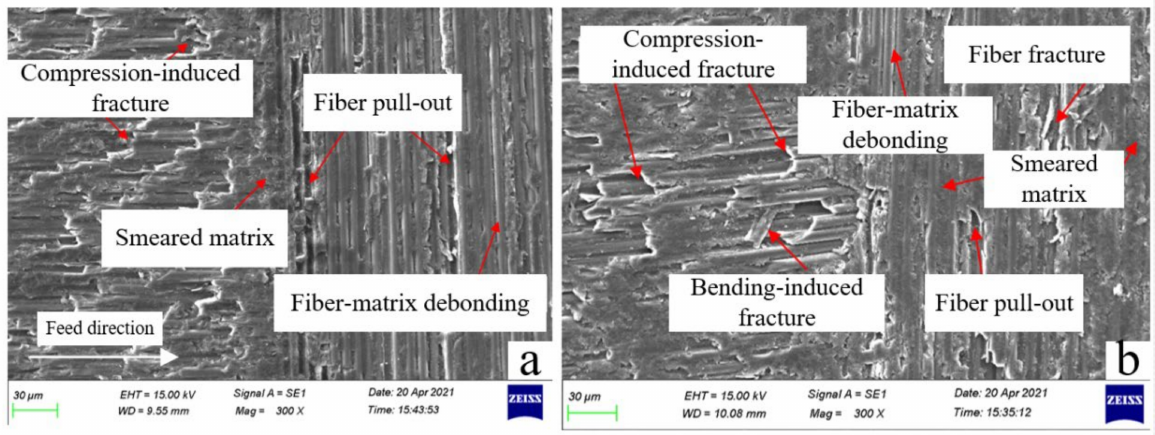
Figure 9. Micrographs of machined surface; ( a ) the maximum equivalent cutting area (n = 6000 r/min, V f = 1 m/min, a p = 1.2 mm); ( b ) the minimum equivalent cutting area ( n = 10,000 r/min, V f = 0.8 m/min, a p = 0.8